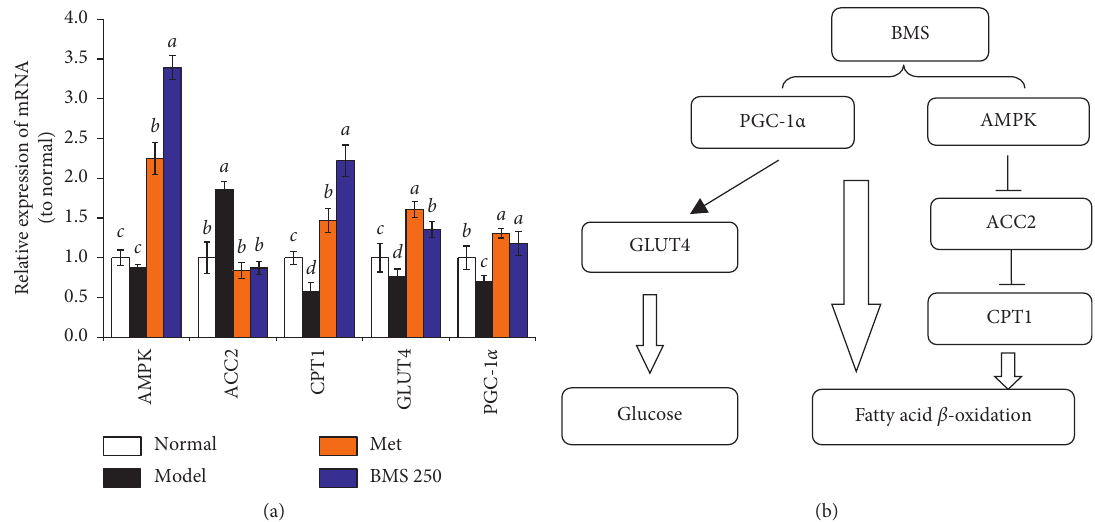
Figure 3: Effect of BMS on fatty acid β -oxidation and glucose intake. (a) mRNA expressions of AMPK, ACC2, CPT1, GLUT4, and PGC-1 α of HepG2-IR cells; (b) potential pathways of BMS involved in the glucose and lipid metabolism. Values are expressed as means ± SE. Statistical analysis was performed using ANOVA. Different superscripts were considered significantly different. Met: metformin; BMS: bitter melon saponins.